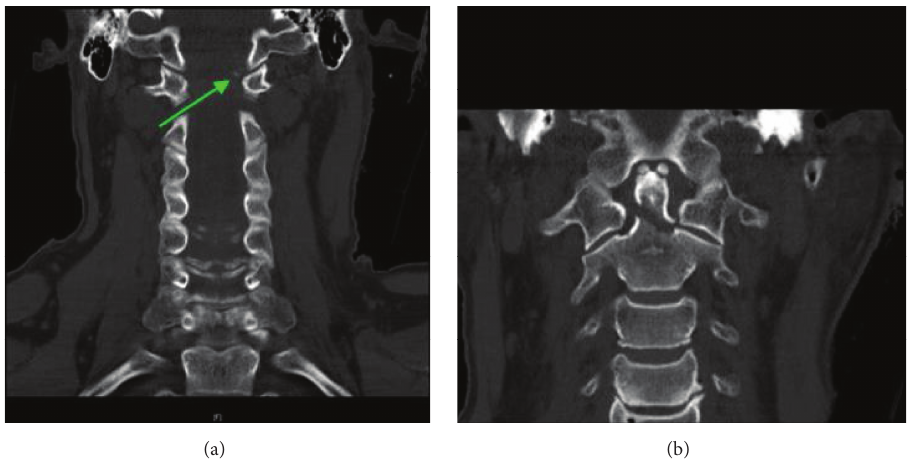
Figure 5: Coronal reconstruction of the cervical spine again demonstrating the reduced occipital condyle-C1 joints bilaterally. There is an avulsion injury of the left occipital condyle consistent with a Type III fracture. The second coronal reconstruction illustrates reduced C1-C2 joint.